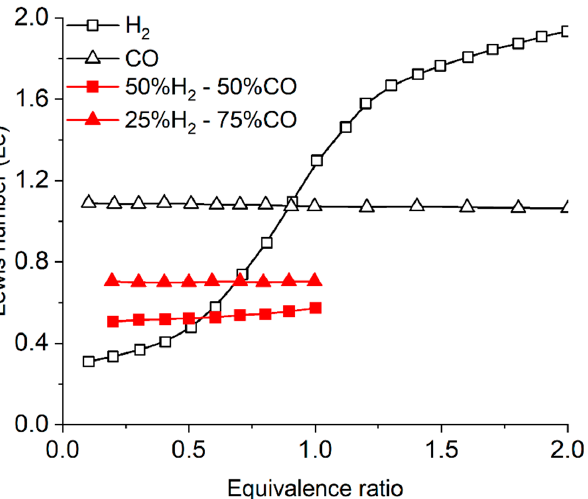
Figure 32. Curves of dependence of the Lewis number on the equivalence ratio (composition of mixtures in volume fractions).